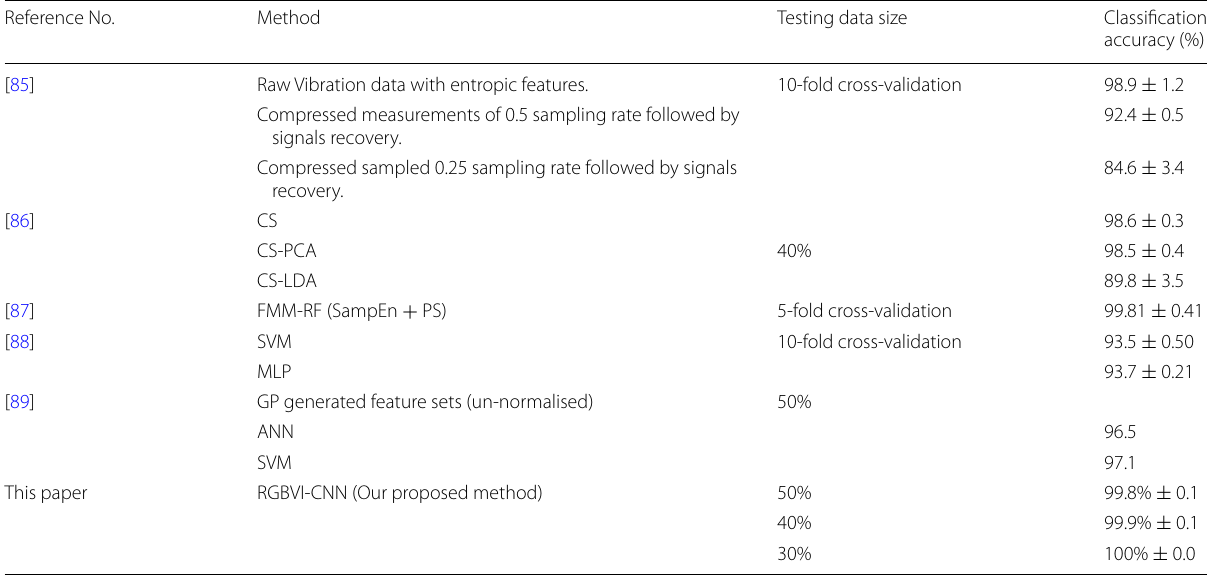
Table 5 Comparison with the classification results from the literature on the bearing dataset Reference No.